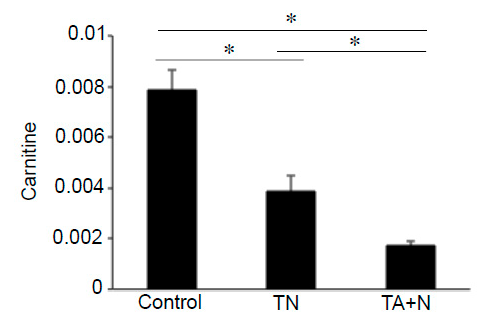
Figure 5. E ff ects of TN and TA + N on carnitine. Human pulmonary artery smooth muscle cells were treated with either TN (100 µ M) or TA (100 µ M) plus niacin (100 µ M) (TA + N) for 10 min. Samples were subjected to metabolomics analysis. Carnitine was found to be di ff erentially expressed between TN and TA + N groups. The bar graphs represent mean ± SEM values of signal intensity. * Values are significantly di ff erent from each other at p < 0.05 ( n = 9).